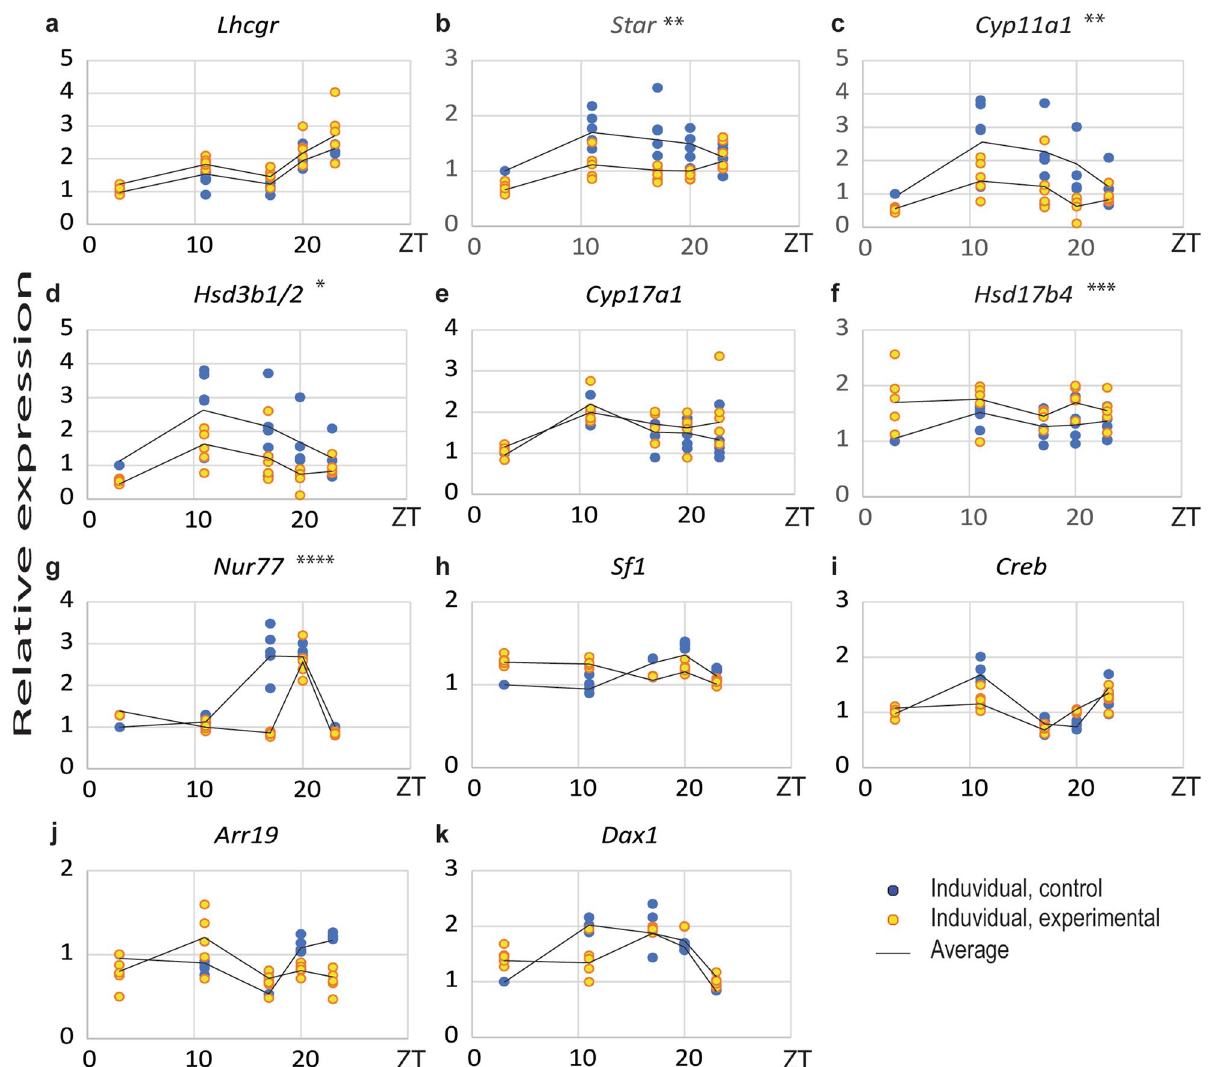
Figure 3. CD changed expression of the genes principally related to mitosteroidogenesis. Leydig cells from both groups were individually isolated at different time points for 24 h. RQ-PCR analysis was performed on steroidogenesis-related genes ( a – f ) and main transcription factors regulating steroidogenic elements expression ( g – k ). CD affected the transcription pattern of genes involved in steroidogenesis in mitochondria ( b – d ) but also positive ( Nur77 , g ) and negative regulatory genes ( Arr19 , j ). Statistical significance: *p < 0.05; **p < 0.01; ***p < 0.005; ****p < 0.001 determined by two-way